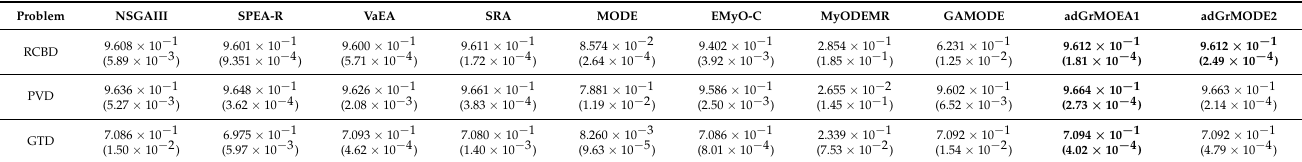
Table 6. Mean and standard deviation values of HV results of proposed algorithm with state of art algorithms on real-world